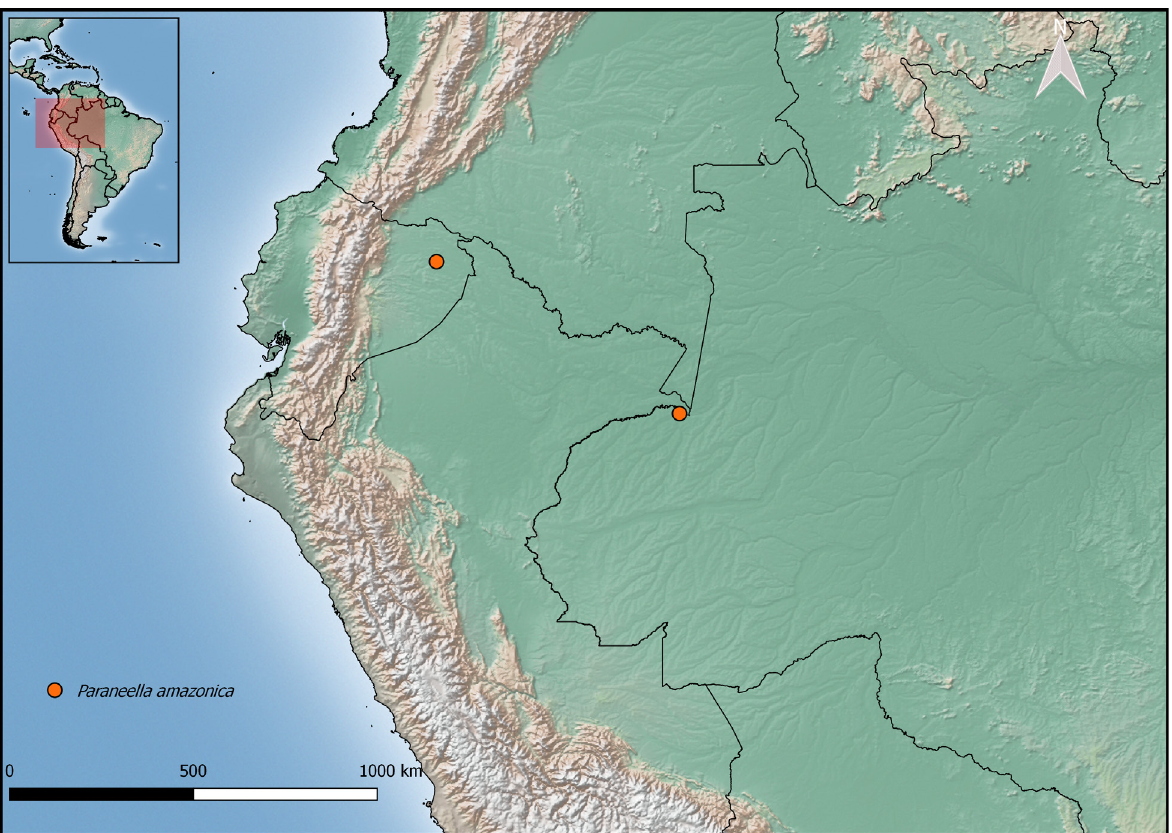
Figure 2. Distributional map of Paraneella amazonica Carvalho